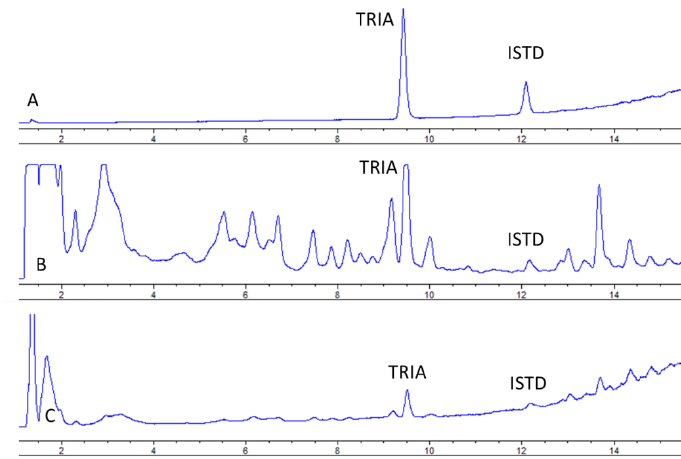
Figure 2. Chromatograms obtained from the analysis of ( A ) IST 5AC and TRIA 0.19% ( w / w ), ( B ) sample containing 200 mg/kg of TRIA and IST, ( C ) spiked sample containing 200 mg/kg TRIA and